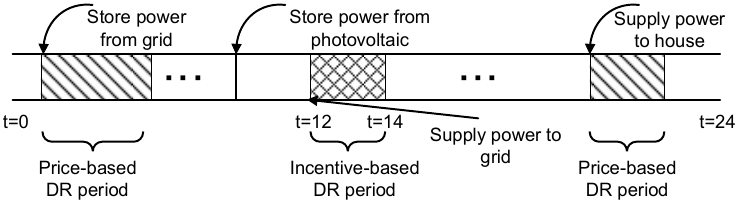
Figure 3. Schematic diagram of BESS daily operation.